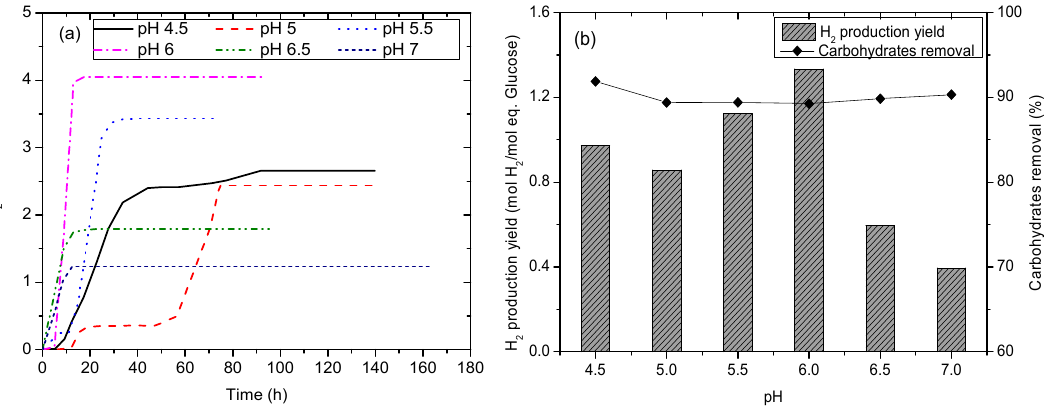
Figure 2. ( a ) Normalized cumulative H 2 production per L of reactor, ( b ) H 2 production yield and carbohydrates removal during the batch dark fermentation of used DNs hydrolysate and EFPs at different pH values.